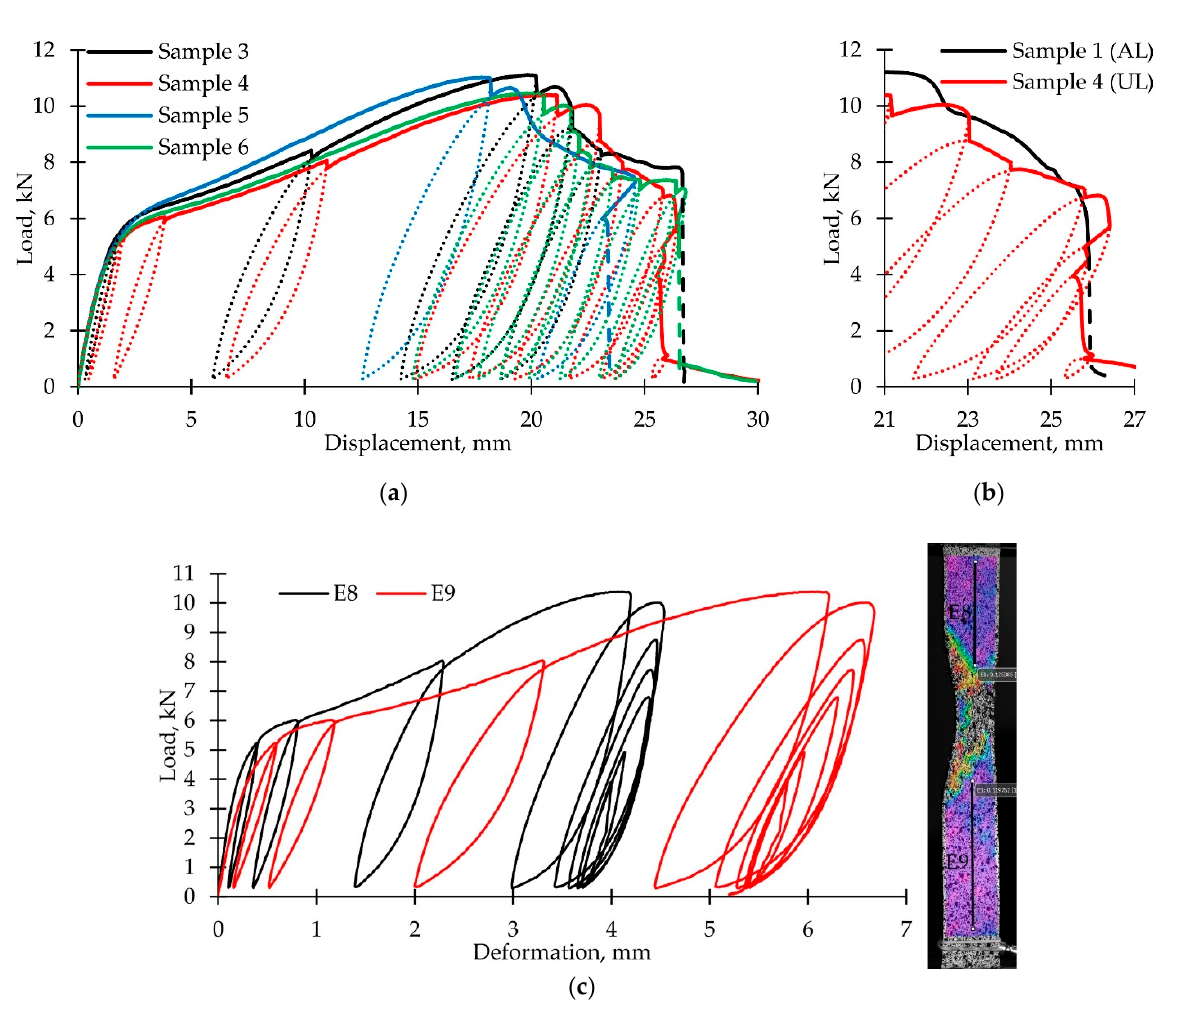
Figure 7. Loading-unloading curves: ( a ) Experimental data; ( b ) comparison between postcritical stage during active loading and loading-unloading; ( c ) loading diagrams of the sample parts above (E 8 ) and below (E 9 ) the neck.